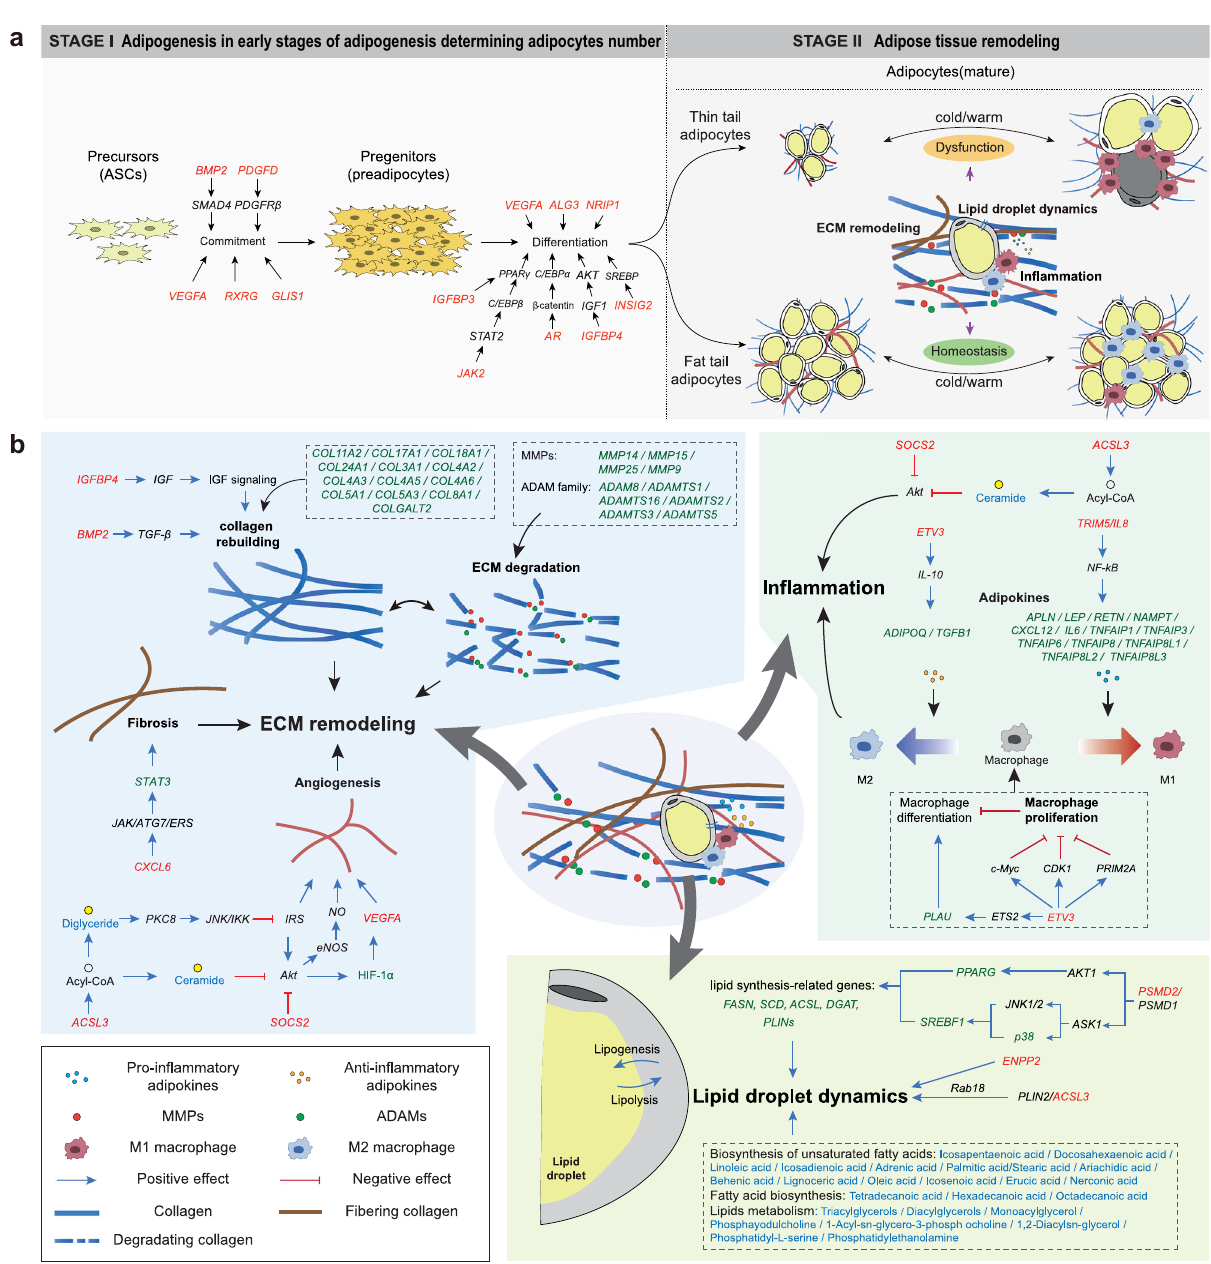
Fig. 6 Schematic of the regulatory mechanisms of adipocytes in sheep in response to environmental changes. a Proposed two-phase regulatory mechanisms in tail adipose tissues of sheep with different fat deposition patterns. Phase I: genetic mutations in fl uence adipocyte number in the early stages of adipogenesis; Phase II: the mature tail adipose tissues in fat-tailed and thin-tailed sheep regulate homeostasis in response to environmental changes. b The detailed regulatory process of homeostasis in mature adipose tissues at the genomic, transcriptomic, and lipidomic levels by ECM remodeling, lipid droplet dynamics, and in fl ammation. The candidate genes identi fi ed by whole-genome selective sweep, transcriptomic and lipidomic analyses are shown in red, green, and blue, respectively. The blue arrow indicates a positive effect, and the red arrow indicates a negative